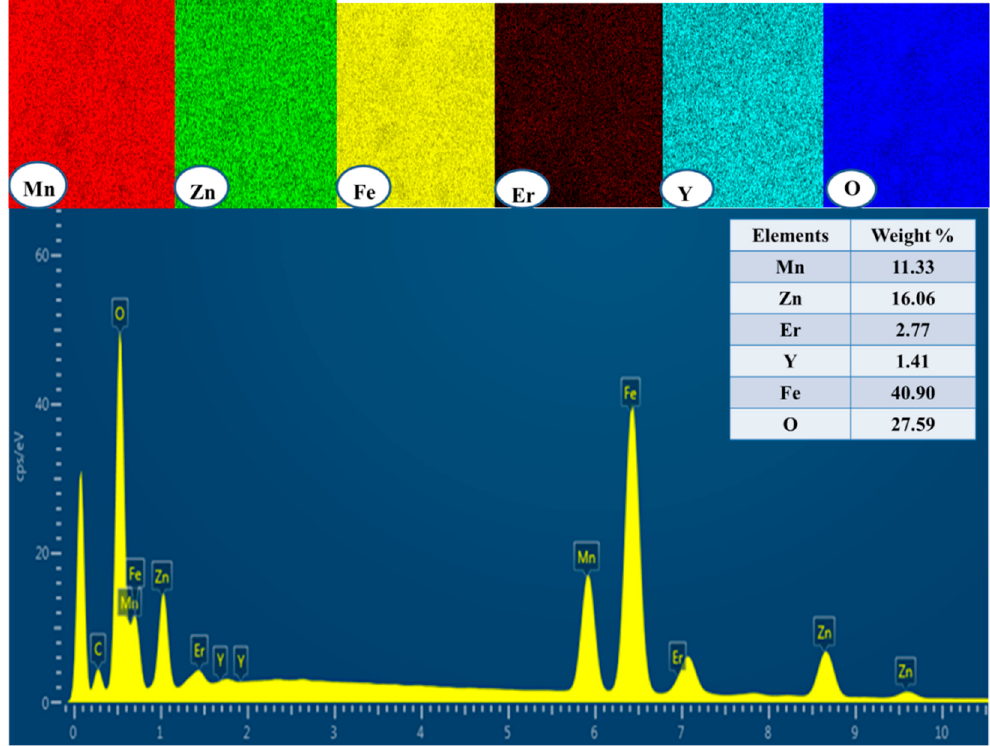
Figure 3. EDX and elemental mapping of Mn 0.5 Zn 0.5 Er x Y x Fe 2-2x O 4 NPs (x = 0.04).